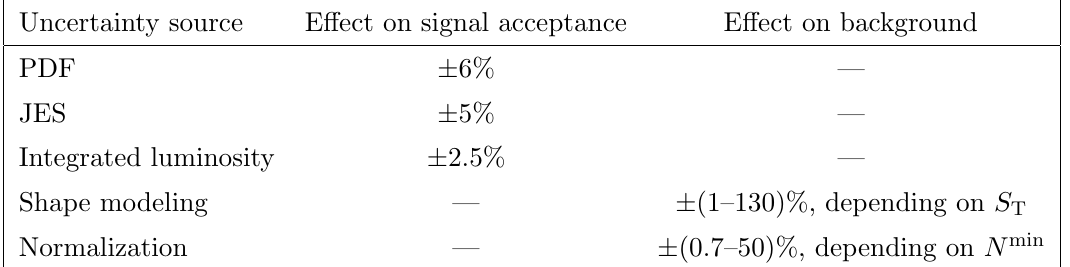
Table 4 . Summary of systematic uncertainties in the signal acceptance and the background esti-